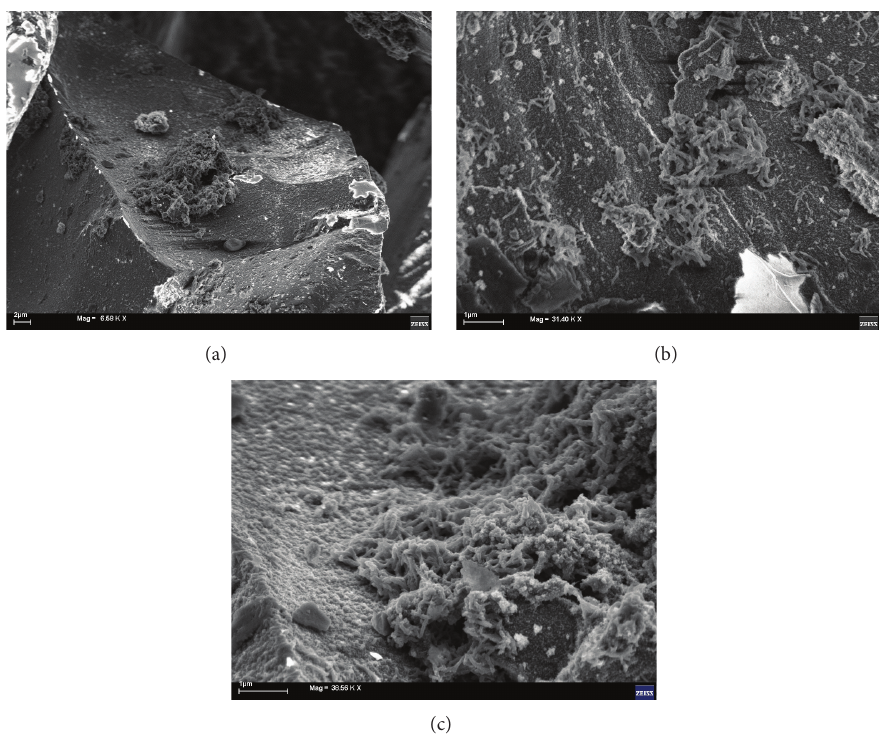
Figure 6: SEM images of PANI-ES/ 𝛼 -Al 2 O 3